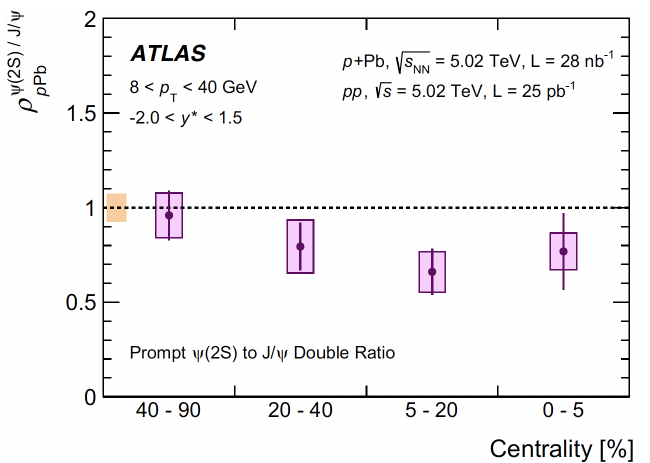
Figure 16. The ψ (2S) to J / ψ ratio is shown in p + Pb collisions in the mid-rapidity region − 2 < y ∗ < 1.5 as a function of centrality over the transverse momentum range 8 < p T < 40 GeV/c [81]. Reprinted with permission from Springer Nature.